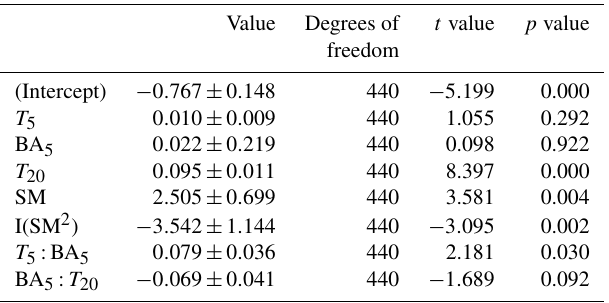
Table 3. Summary of the linear mixed-effects model testing the main hypothesis of the effect of nearby tree basal area on soil respi- ration (the dependent variable). Terms tested include soil tempera- ture at 5 and 20cm ( T 5 and T 20 respectively), basal area (BA), and soil moisture (SM). Model AIC = 381.6, marginal R 2 = 0 .